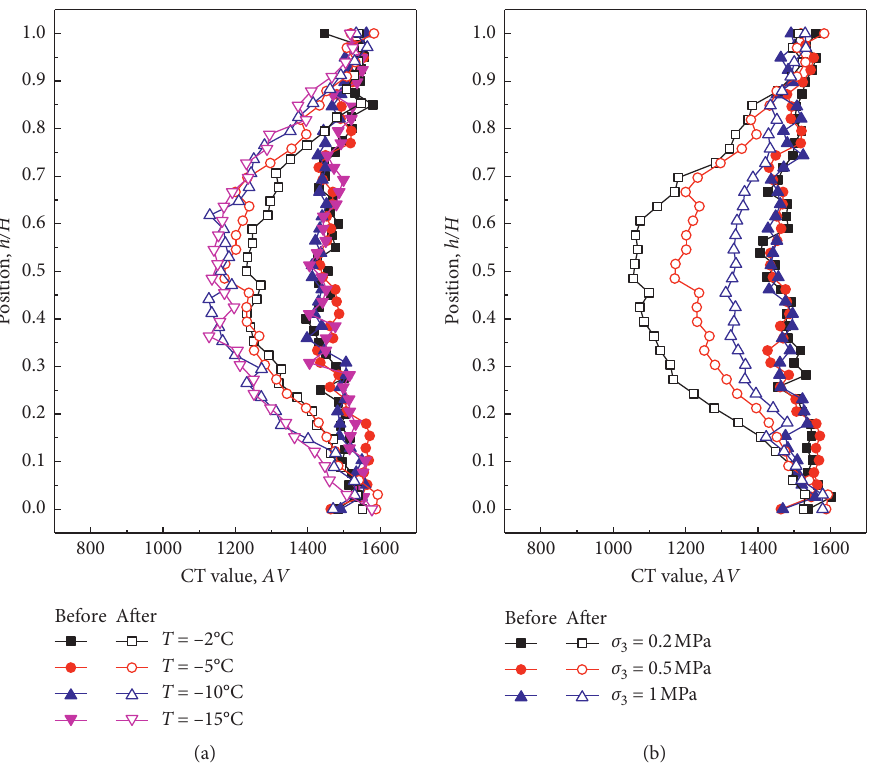
Figure 9: Relationship between CT value and normalized height h / H for specimens before and after testing: (a) confining pressure σ 3 � 0.5MPa; (b) frozen temperature T �− 5 ° C.